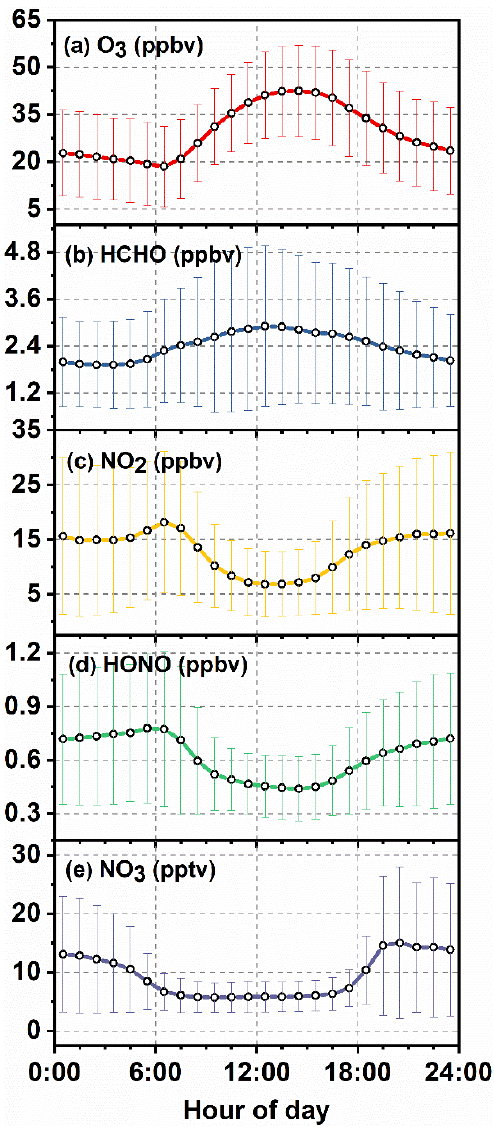
Figure 4. The mean diurnal variations in O 3 ( a ), HCHO ( b ), NO 2 ( c ), HONO ( d ), and NO 3 ( e ) from September 2019 to August 2020 in Nanhui, Shanghai. (The error bars indicate the standard deviations).